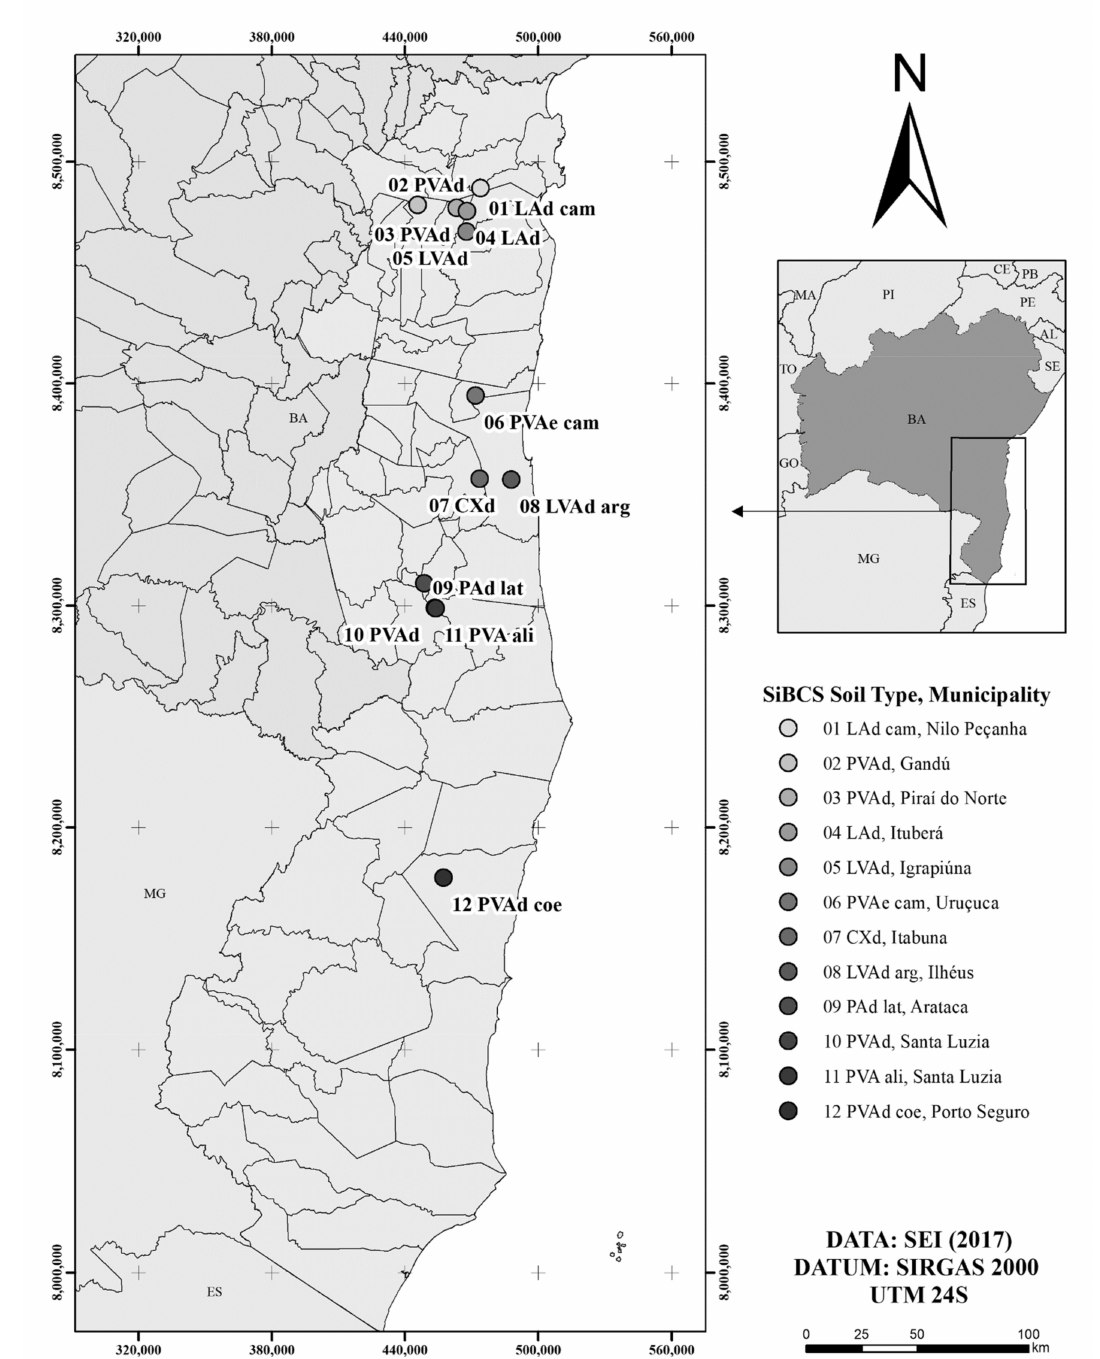
Figure 1. Cacao crop sites represented by different edaphic conditions in the humid zone of southeast Bahia, Brazil: ambisolic Dystrophic Yellow Latosol (01 LAd cam); typic Dystrophic Red–Yellow Argisol (02 PVAd); abrupt Dystrophic Red–Yellow Argisol (03 PVAd); typic Dystrophic Yellow Latosol (04 LAd); typic Dystrophic Red–Yellow Latosol (05 LVAd); cambisolic Eutrophic Red–Yellow Argisol (06 PVAe cam); typic Dystrophic Haplic Cambisol (07 CXd); argisolic Dystrophic Red–Yellow Latosol (08 LVAd arg); latosolic Dystrophic Yellow Argisol (09 PAd lat); typic Dystrophic Red–Yellow Argisol (10 PVAd); typic Alitic Red–Yellow Argisol (11 PVA ali); abrupt Cohesive Dystrophic Red–Yellow Argisol (12 PVAd